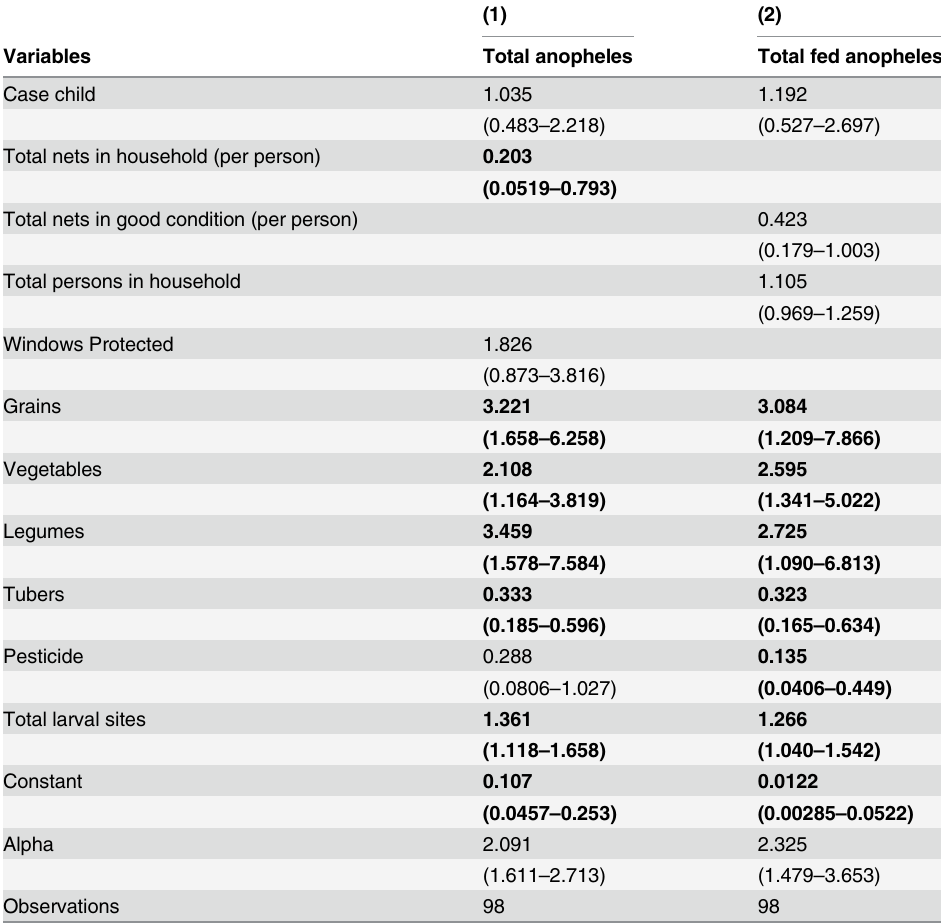
Table 5. Multivariable negative binomial regressions of anopheles mosquito